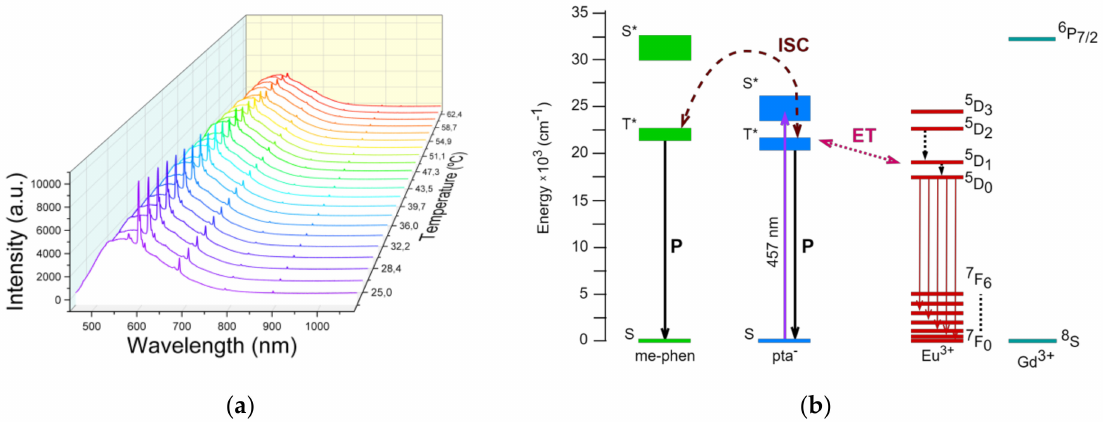
Figure 5. ( a ) Emission spectra of [Eu 0.0135 Gd 0.9865 (pta) 3 me-phen] under 457 nm in the range of 23–62 ◦ C; ( b ) Partial energy-level diagram indicating the transitions observed under the excitation of the 457 nm laser where ISC (intersystem crossing) occurs; ET is energy transfer; P is phosphorescence. Non-radiative relaxation processes are represented by dashed arrows [29].